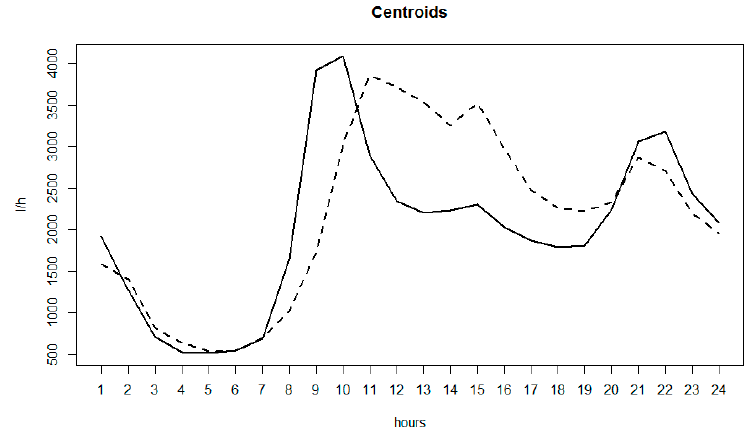
Figure 7. Case 1—a residential customer: results from clustering (dotted line is the pattern associated with weekends and holidays).